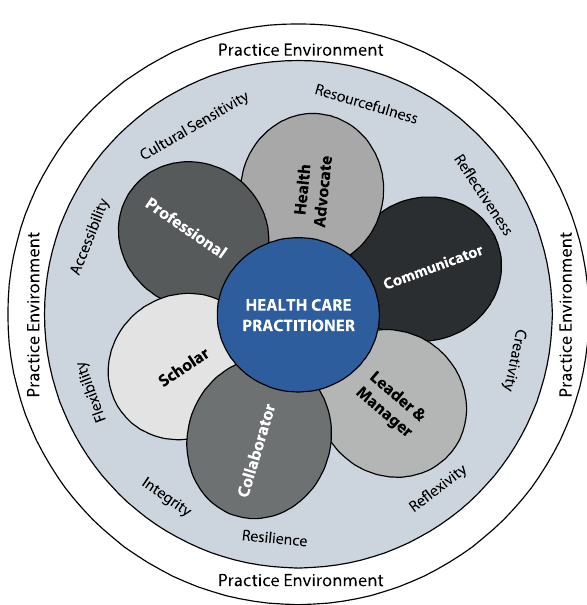
Figure 1: Core graduate competencies for Health Care Professionals at UKZN. Source: Adapted from the HPCSA Core Competencies for Undergraduate Programmes in South Africa (2014) with permission of the HPCSA Undergraduate Committee obtained March 2014. 4